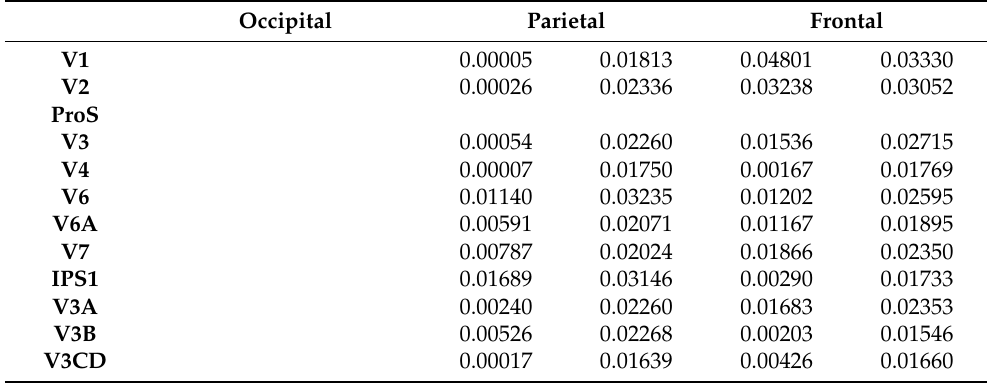
Figure 3. Results for WPLI connectivity. ( a ) Values of ∆ ( r a , B ) , for all sector combinations in color code. ( b ) Values of Γ ( r a , B ) , for all sector combinations in color code. ( c ) Connectome plots for the three relevant sector combinations computed from G. Red/green/blue ROI names belong to occipital/parietal/frontal sectors, respectively. The gray level of lines encodes the magnitude of Γ ( r Γ ( r a , r b ) while the gray level of the dot encodes a , B ) . In the inset the color code is explained: assigning red/green/blue colors to occipital/parietal/frontal sectors, respectively, the intensity of each area represents the overall magnitude of the parameter of interest, while the color encodes the proportion of the magnitude due to connectivity to the other sectors. So, for example, a parietal area more towards blue has more consistent phase relationship to the frontal sectors, while, if more towards red, the most relevant connection is to the occipital sector. Table 2. Connectivity values for all ROIS towards each of the three sectors. Values of Γ ( r a , b ) and ∆ ( r , B ) computed from WPPC are